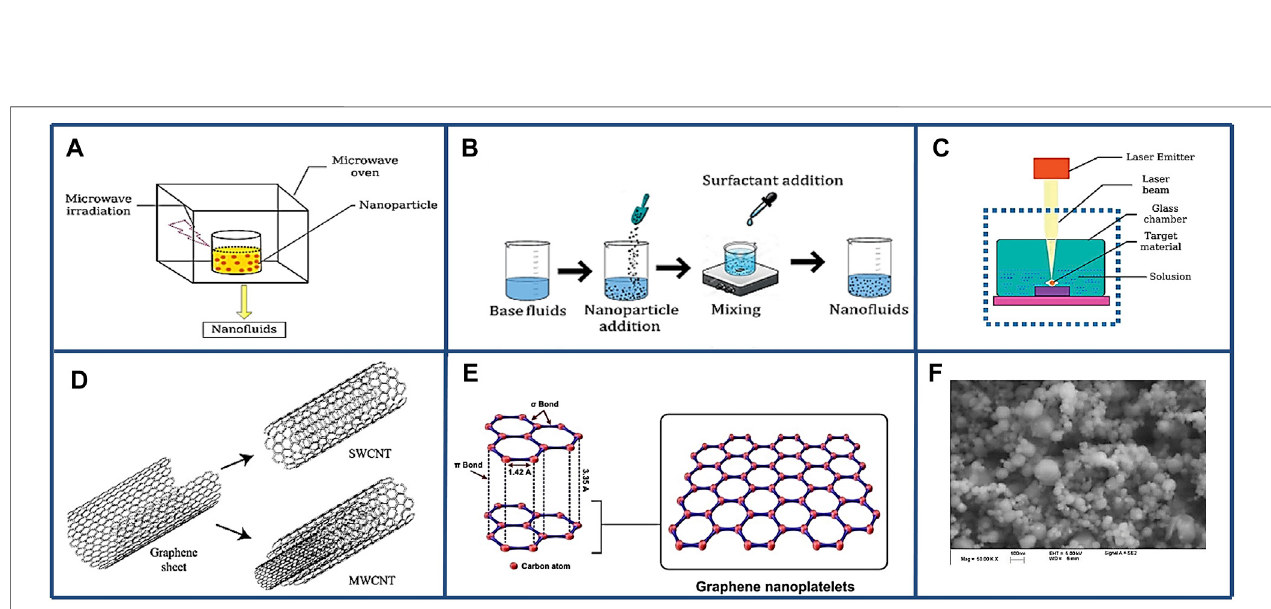
FIGURE 2 | Preparation method of nano fl uids, structure, and morphology of nanoparticles. (A) One-step method, (B) Two-step method, and (C) One-step method. Reproduced with permission (Mukherjee et al., 2018). Copyright 2018, Wiley Online Library. (D) Single-wall CNT and Multi-wall CNT. Reproduced with permission (Yazid et al., 2016). Copyright 2016, Elsevier. (E) Graphene nanoplatelets. Reproduced with permission (Madhad et al., 2021). Copyright 2021, SAGE Journals. (F) SEM CuO nanoparticles Reproduced with permission (Liu et al., 2006). Copyright 2006, Wiley Online Library.